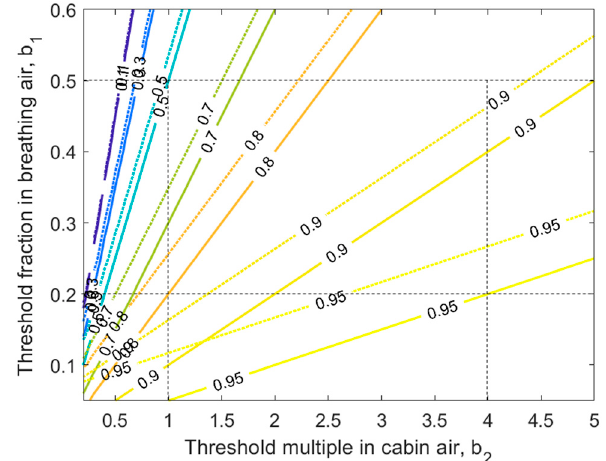
Figure 6. Isolines display the fraction of the clean air, f PUR , that has to be delivered to the breathing zone of the mobile machine operator, to ensure the required quality of the breathing air (threshold fraction) for the particular composition of the cabin air (threshold multiple). Solid lines refer to the substances emitted only outside the cabin such as NO, NO 2 , and CO. Dotted lines refer to CO 2 .